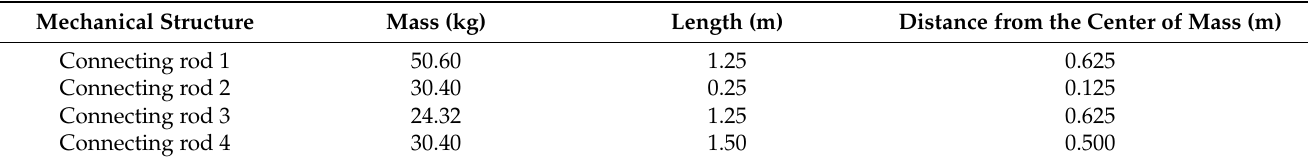
Table 2. Structural parameters of palletizing robot